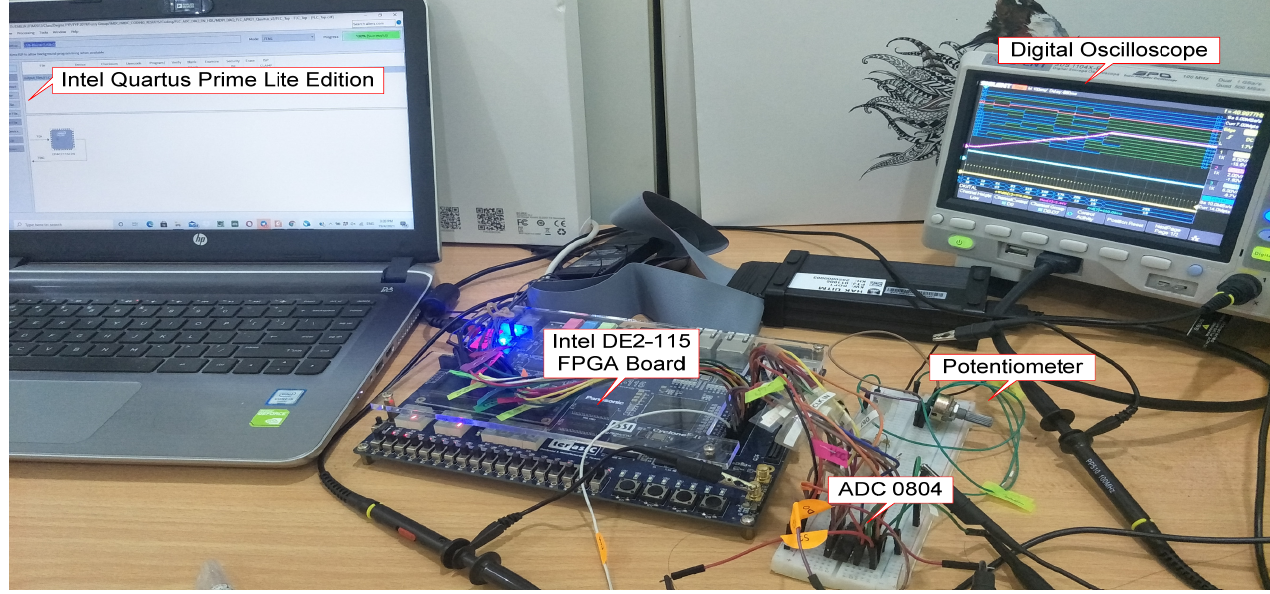
Figure 13. Hardware measurement setup using an Intel field-programmable gate array (FPGA) (DE2-115) board, an ADC (ADC0804) circuit, a rotary 10k ohm potentiometer and a digital oscilloscope.